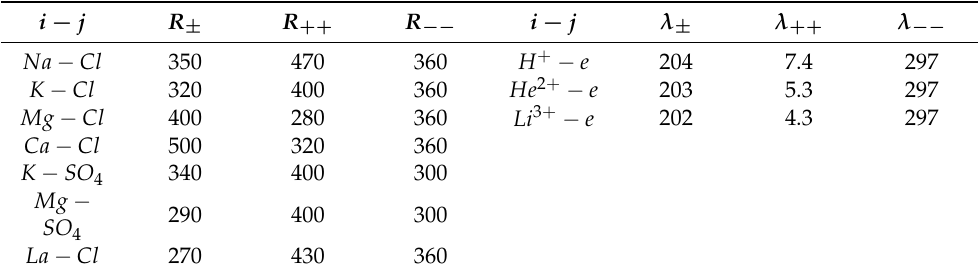
Table 1. Table of contact distances for several ion pairs including alkaline earth metal ions, sulfate ions and adapted “ideal” seawater ions according to [18]. Further we give for quantum plasmas some typical values of the De Broglie thermal wavelength at T = 10 4 K (all length given in pm). i − j R ± R ++ R −− i − j λ ± λ ++ λ −− Na − Cl 350 470 360 H + − e 204 7.4 297 K − Cl 320 400 360 He 2 + − e 203 5.3 Mg − Cl 400 280 360 Li 3 + − e 202 4.3 297 Ca − Cl 500 320 360 K − SO 4 340 400 300 Mg − 290 400 300 SO 4 La − Cl 270 430